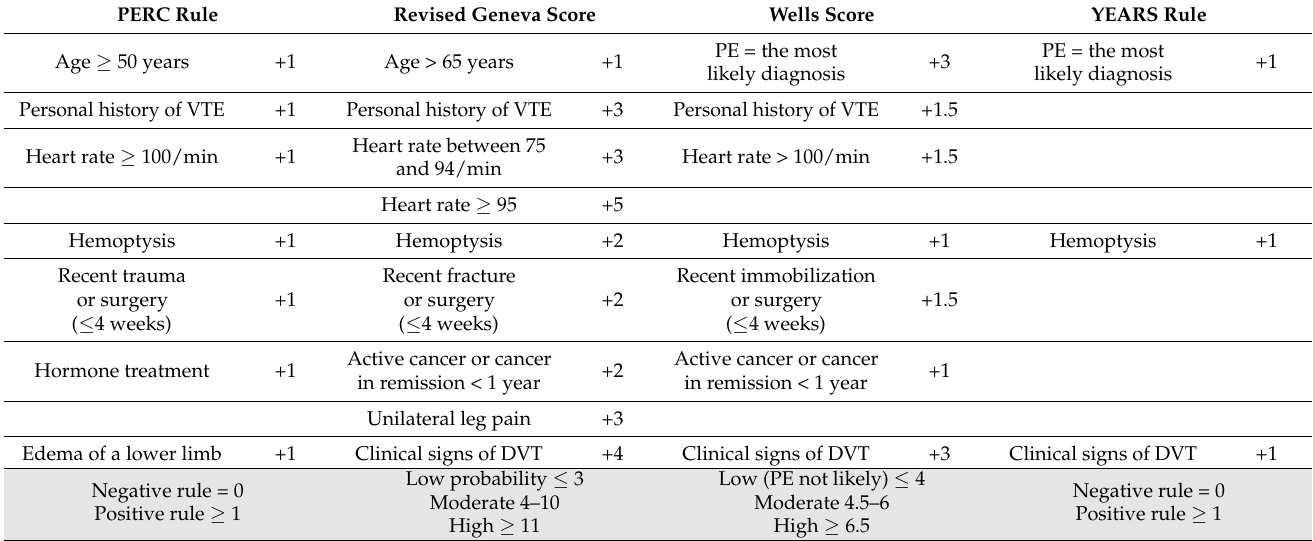
Table 1. Clinical rules and